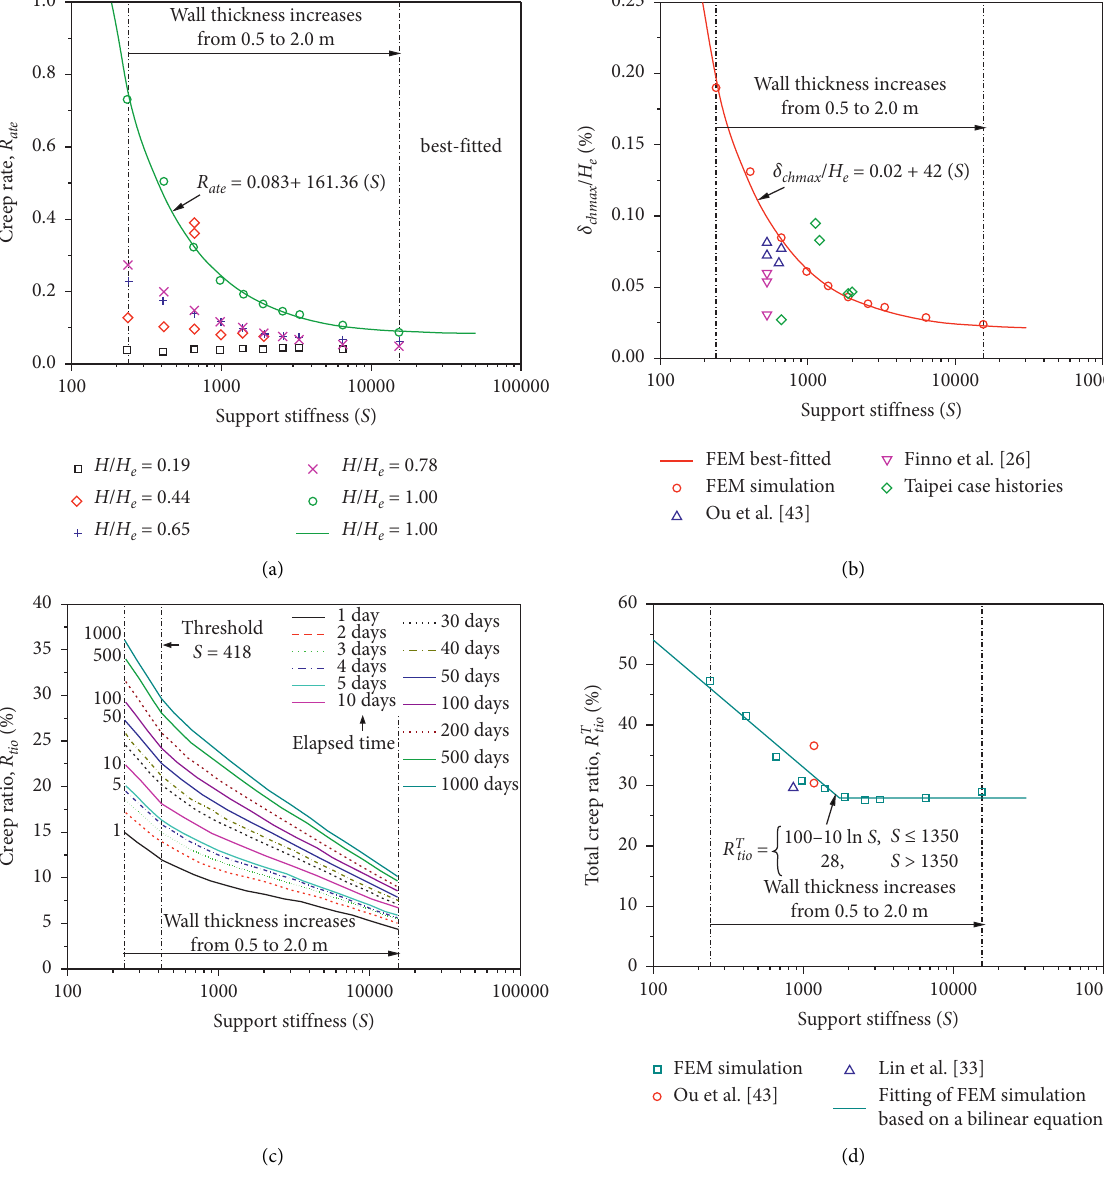
Figure 5: Effects of support stiffness on (a) creep rate, (b) normalized maximum wall displacement due to soil creep, (c) creep ratio, and (d) total creep ratio, modified from